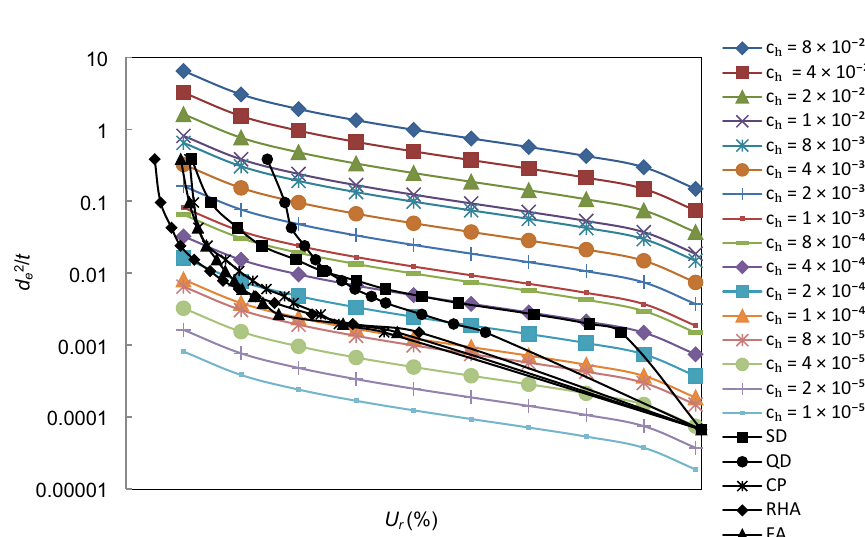
Fig. 6 Theoretical log 10 ( d e 2 / t ) versus U r curve with experimental curves for KC with different drain material at P 20 =